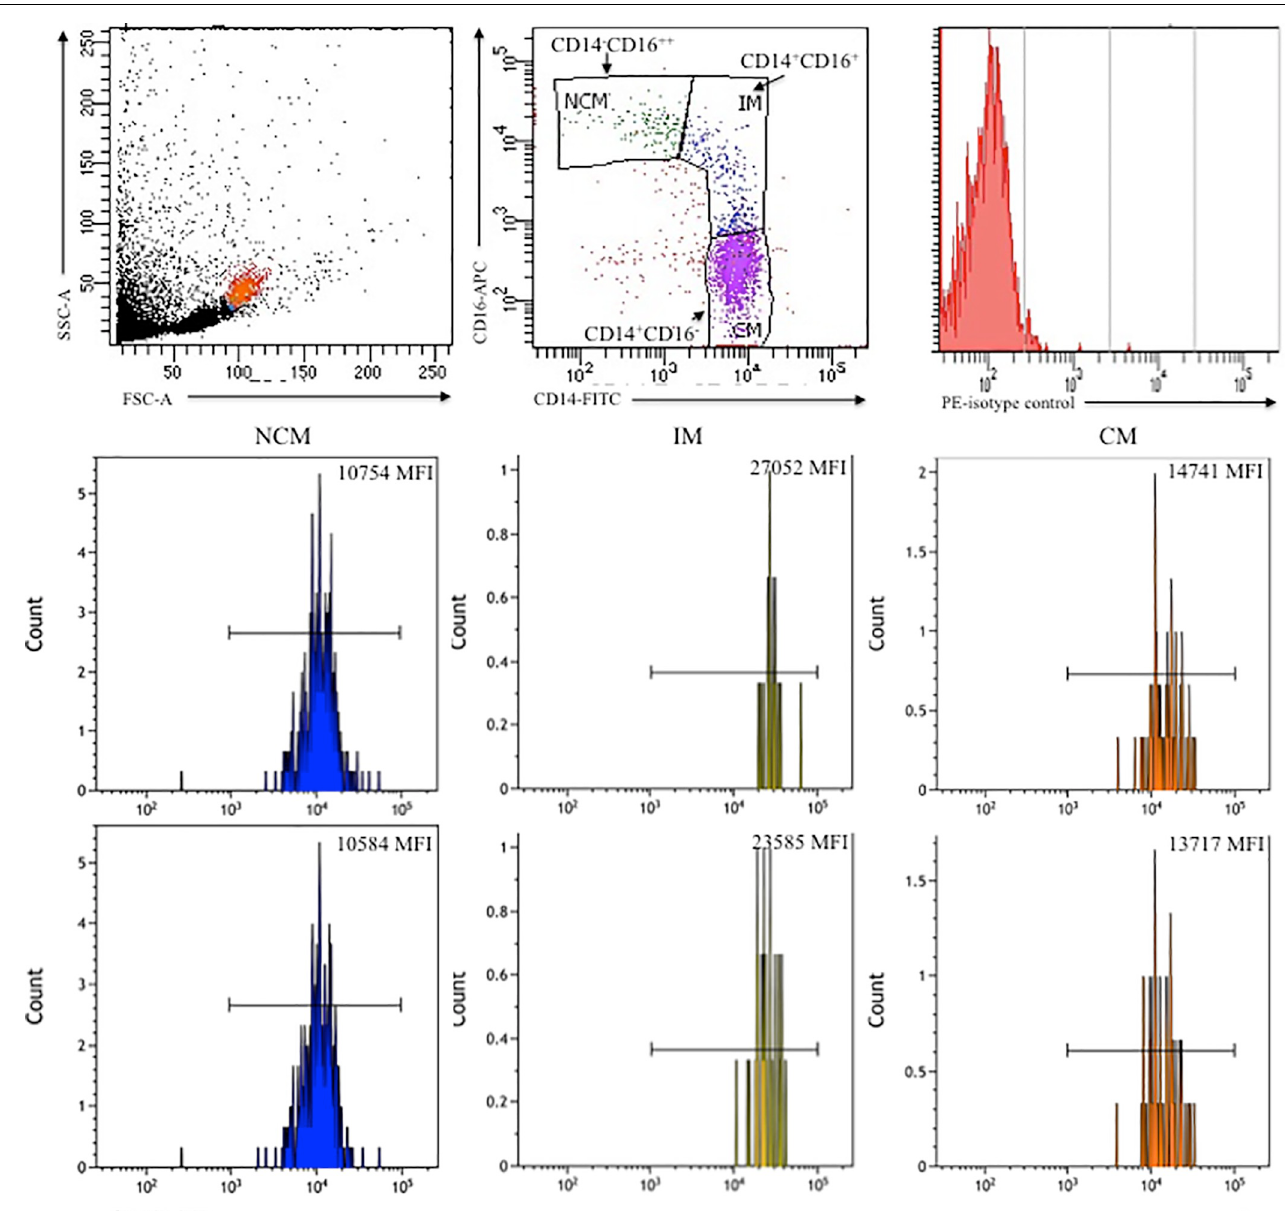
Fig 3. β 2AR expression among Mo subsets. PBMC were incubated for 1 h with anti- β 2AR polyclonal Ab and next stained with a secondary F´(ab)2 PE mAb. Next, PBMC were labeled with anti-CD14-FITC and–CD16-PE mAbs. A) Representative dot plot depicts FSC and SSC to identify monocytes. B) PE-isotype control is shown in a histogram. C) Histograms correspond to β 2AR staining within the each Mo subset as follows: the expression of β 2AR on CD14 - CD16 ++ or NCM (left panels), on CD14 + CD16 + or IM (middle panels), and on CD14 ++ CD16 - or CM (right panels). MFI is indicated. Results shown are from a representative lean individual (top panels) and a subject with obesity (bottom panels). MFI = mean fluorescence intensity.